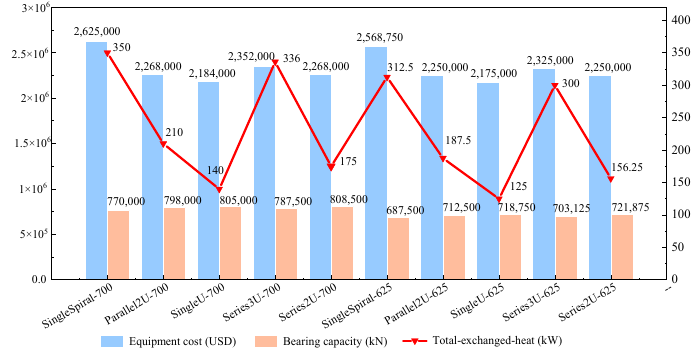
Figure 9. Querying results of equipment cost and vertical bearing capacity.